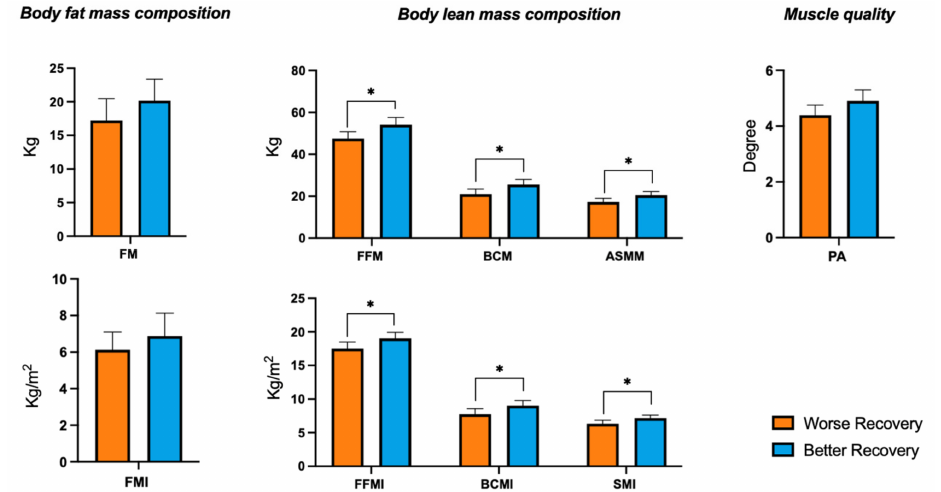
Figure 1. Analysis of body composition parameters at admission and rehabilitation recovery. Com- parison of BIA parameters at baseline between patients with better recovery ( ∆ BI > 10) or with worse recovery, ( ∆ BI ≤ 10). FM, fat mass; FMI, fat mass index; FFM, fat-free mass; FFMI, fat-free mass index; ASMM, appendicular skeletal muscle mass; SMI, skeletal muscle Index; BCM, body cell mass; BCMI, body cell mass index; PhA, phase angle. Mean bars and 95% of CI are reported. * refers to the statistically significant difference ( p < 0.05), according to the Mann–Whitney U